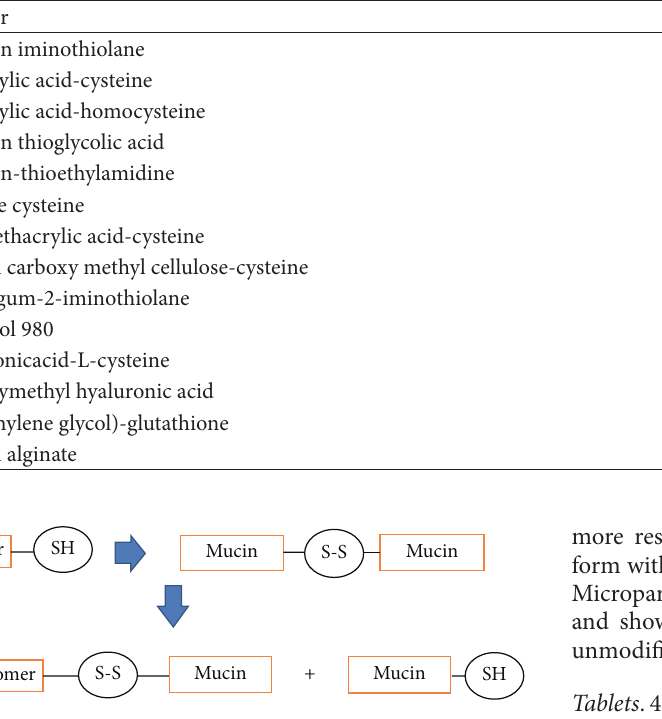
Figure 2: Mechanism of mucoadhesion of